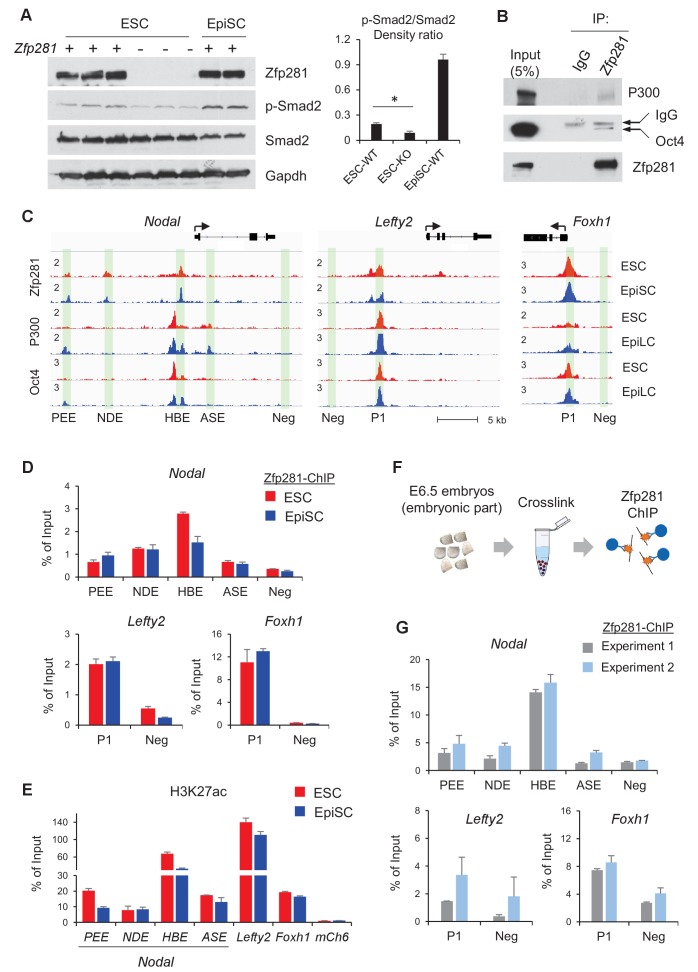
Zfp281 cooperates with Oct4 and P300 for regulation of genes encoding Nodal pathway components.(A) Protein expression of p-Smad2 and Smad2 in WT (J1, CJ7, WT clone no 3), Zfp281KO (clone no. 2.6, 7, 3.34) ESC and WT EpiSC (OEC2, EpiSC9) cells. P-Smad2/Smad2 density ratios were quantified on the right panel. Student T-test was used examine statistical significance, *p<0.05. (B) Co-IP of Zfp281 with Oct4 and P300 in EpiSCs. The non-specific band is IgG heavy chain. (C) ChIP-seq tracks of Zfp281, Oct4 and P300 in ESCs and EpiSCs/EpiLCs at Nodal, Lefty2, and Foxh1 loci. Intensities are shown as mapped reads per million total mapped (RPM). (D) ChIP-qPCR of Zfp281 at Nodal, Lefty2, and Foxh1 regulatory regions in in ESCs and EpiSCs. (E) ChIP-qPCR of histone markers H3K27me at Nodal, Lefty2, and Foxh1 regulatory regions in ESCs and EpiSCs. (F) Diagram of ChIP experiments on E6.5 (WT) embryos. (G) ChIP-qPCR of Zfp281 at Nodal, Lefty2, and Foxh1 regulatory regions in E6.5 (WT) embryos. ChIP experiments were performed in two independent replicates. ChIP-qPCR primer sequences are provided in Figure 7—source data 1.10.7554/eLife.33333.029Figure 7—source data 1.ChIP-qPCR primer sequences.